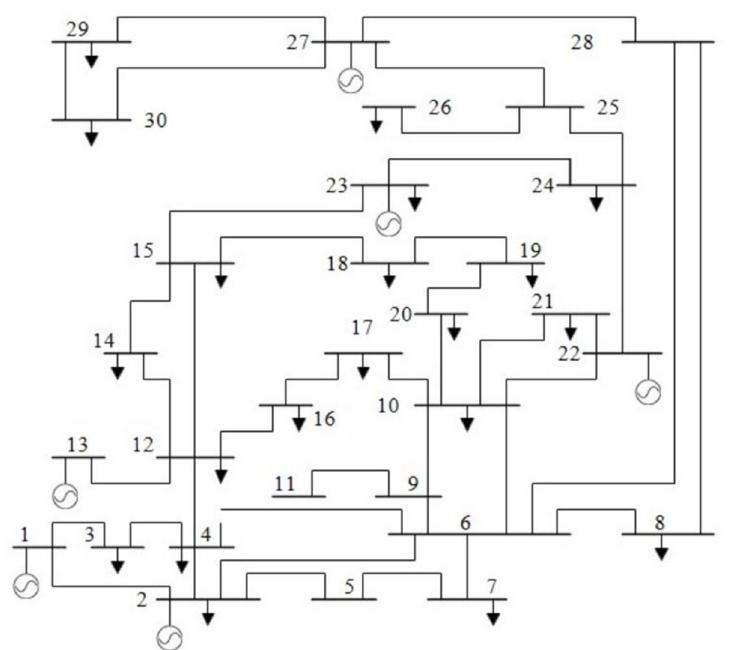
Fig 3. IEEE-30 bus system single line diagram.